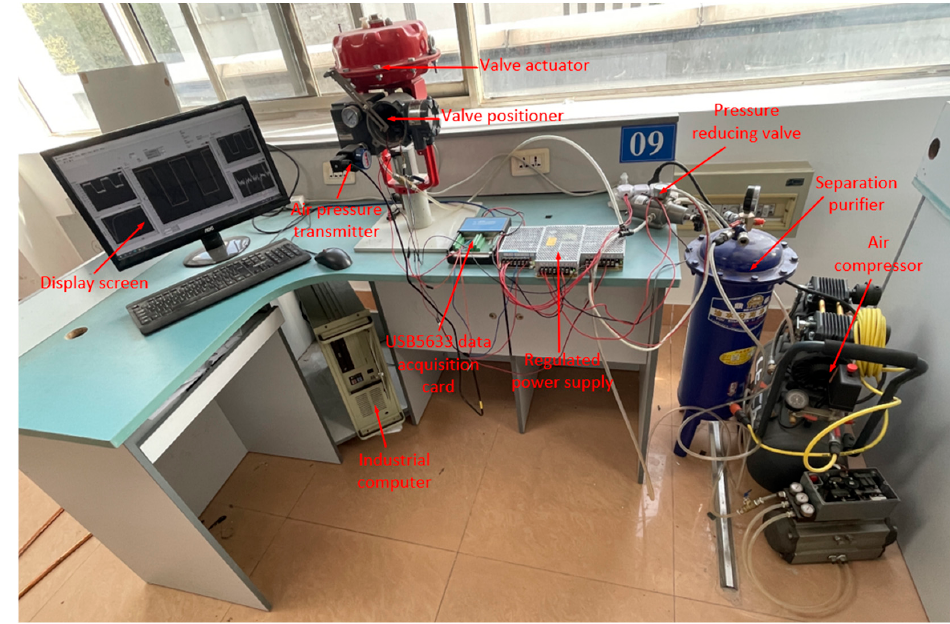
Figure 16. ( a ) Tracking curve of sinusoidal signal; ( b ) tracking error of sinusoidal signal.